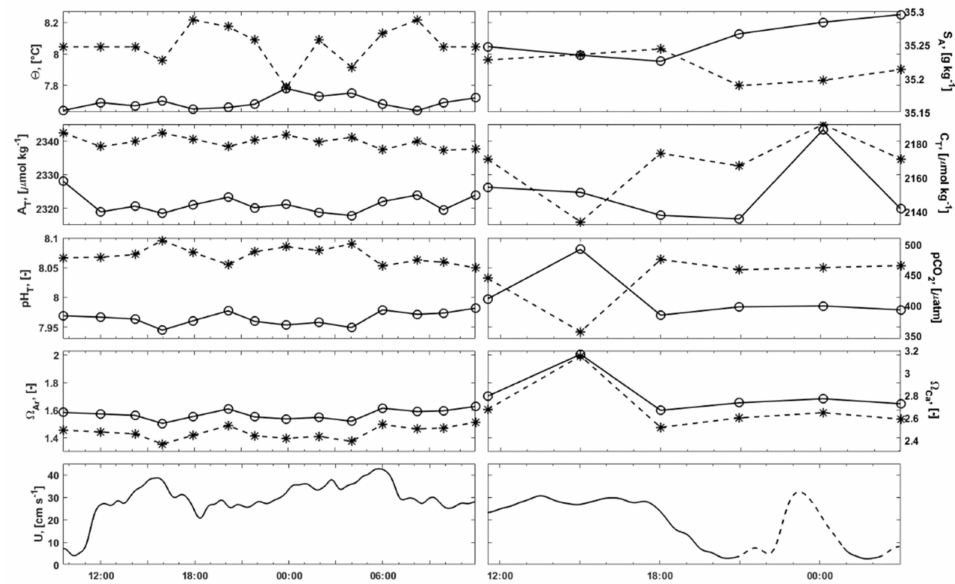
Figure 6. Short time series (x-axes) of carbonate system fluctuations on 20–21 October 2016 at Huglhammaren wall reef (left panels) and on 3–4 January 2017 at Nakken bank reef (right panels) at 200 m depth for (first row) temperature, Θ (o) and salinity, S A (*), (second row) total alkalinity, A T (o) and total inorganic carbon, C T (*), (third row) pH T (o) and partial CO 2 pressure, pCO 2 (*), (fourth row) aragonite saturation, Ω Ar (o) and calcite saturation, Ω Ca (*), and (fifth row) 1 h running mean of the horizontal flow at 200 m depth from SLM lander at NK bank reef, U with southward (solid line), and northward (dashed line)